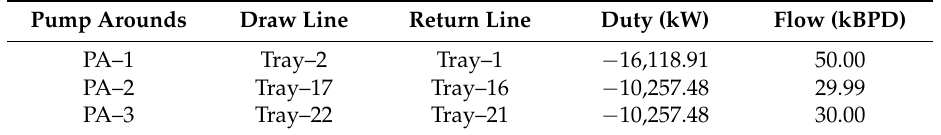
Table 4. Specifications for Pump-Arounds